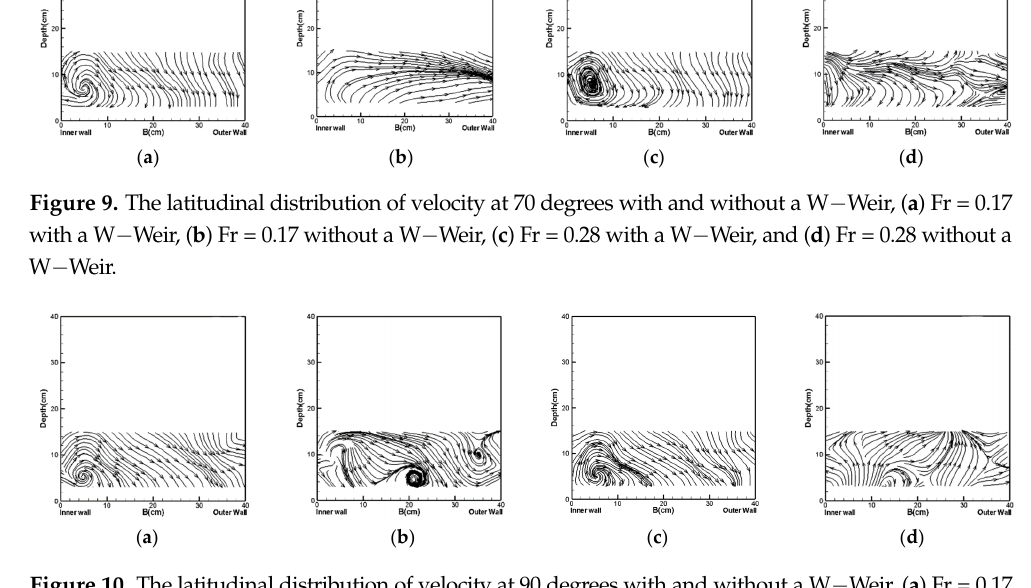
Figure 9. The latitudinal distribution of velocity at 70 degrees with and without a W − Weir, ( a ) Fr = 0.17 with a W − Weir, ( b ) Fr = 0.17 without a W − Weir, ( c ) Fr = 0.28 with a W − Weir, and ( d ) Fr = 0.28 without a W − Weir.